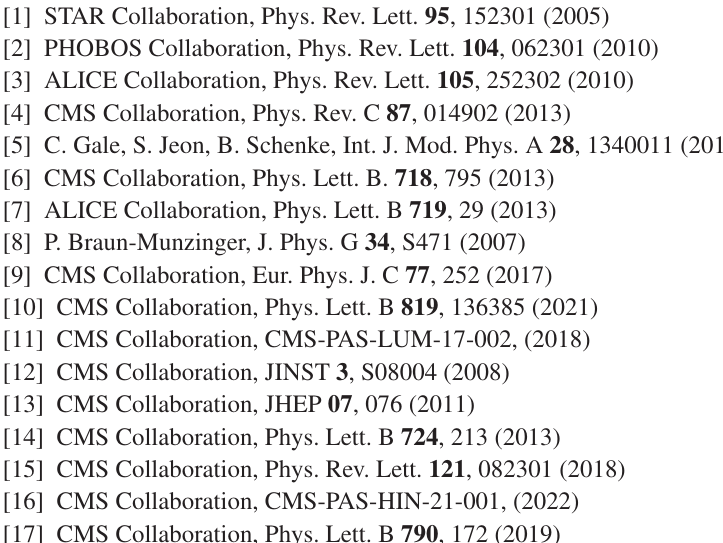
Figure 2. (Left) The p T dependent v sub results from PbPb collisions at 5.02 TeV, measured within the 10–90% centrality range [10]. (Right) The same distribution is also compared with the v sub 2 . 4 in pPb collisions at 8.16 TeV for 180 35 is used estimate and account for the dijet contribution [17]. The vertical bars denote statistical uncertainties and the rectangular boxes systematic uncertainties, while the widths of the boxes represent the p T bin